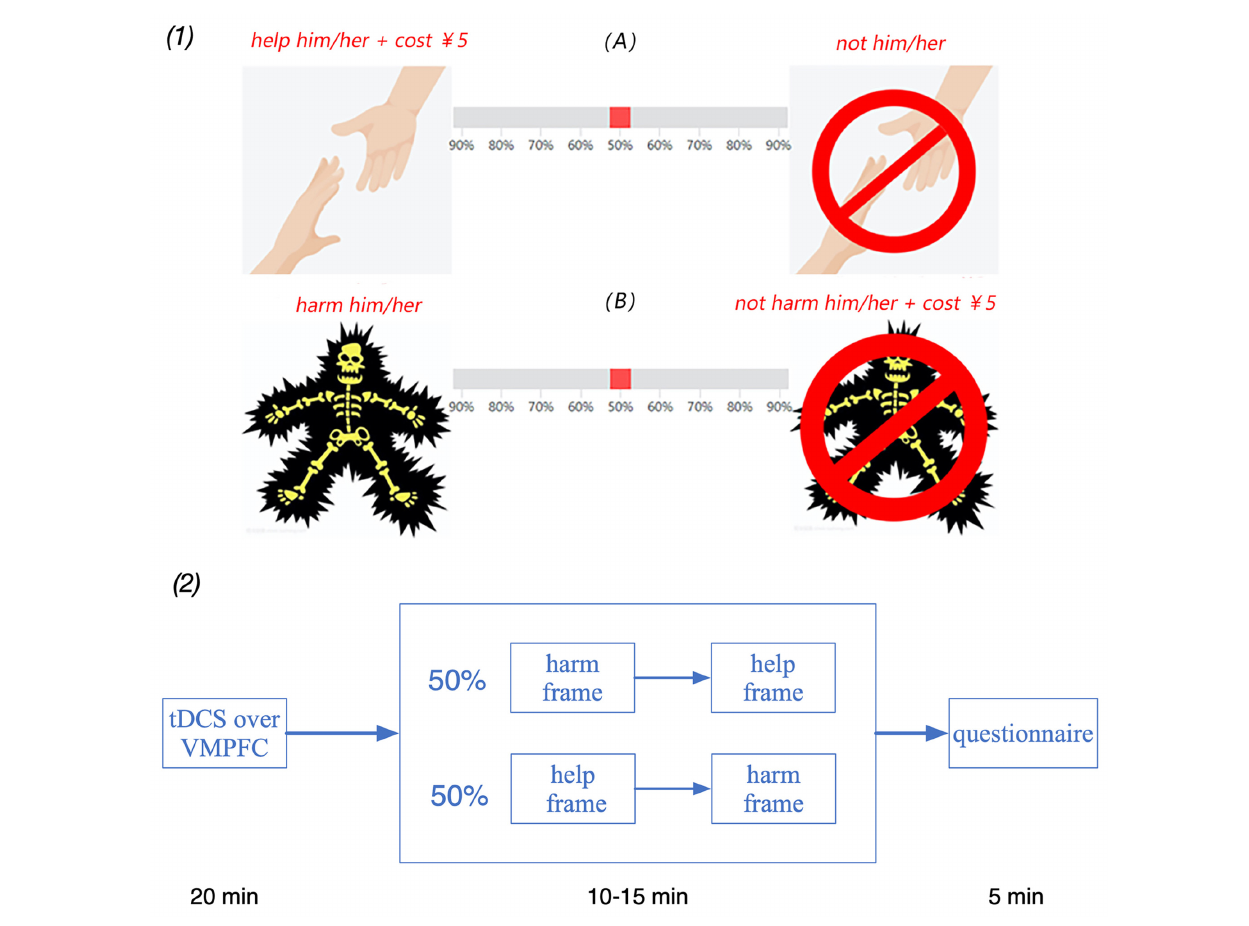
FIGURE 2 | (1) Experimental design of the social frame task. (2) Schematic representation of the configuration of experiments. The participant was asked to complete the social frame task, including the harm frame and the help frame, after 20 min of